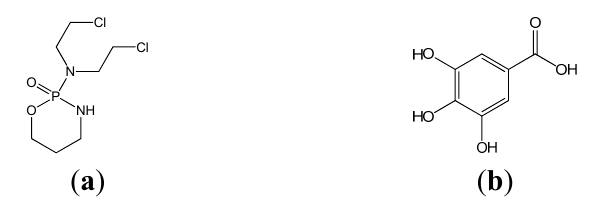
Figure 1. Chemical structure of cyclophosphamide ( a ), and gallic acid ( b